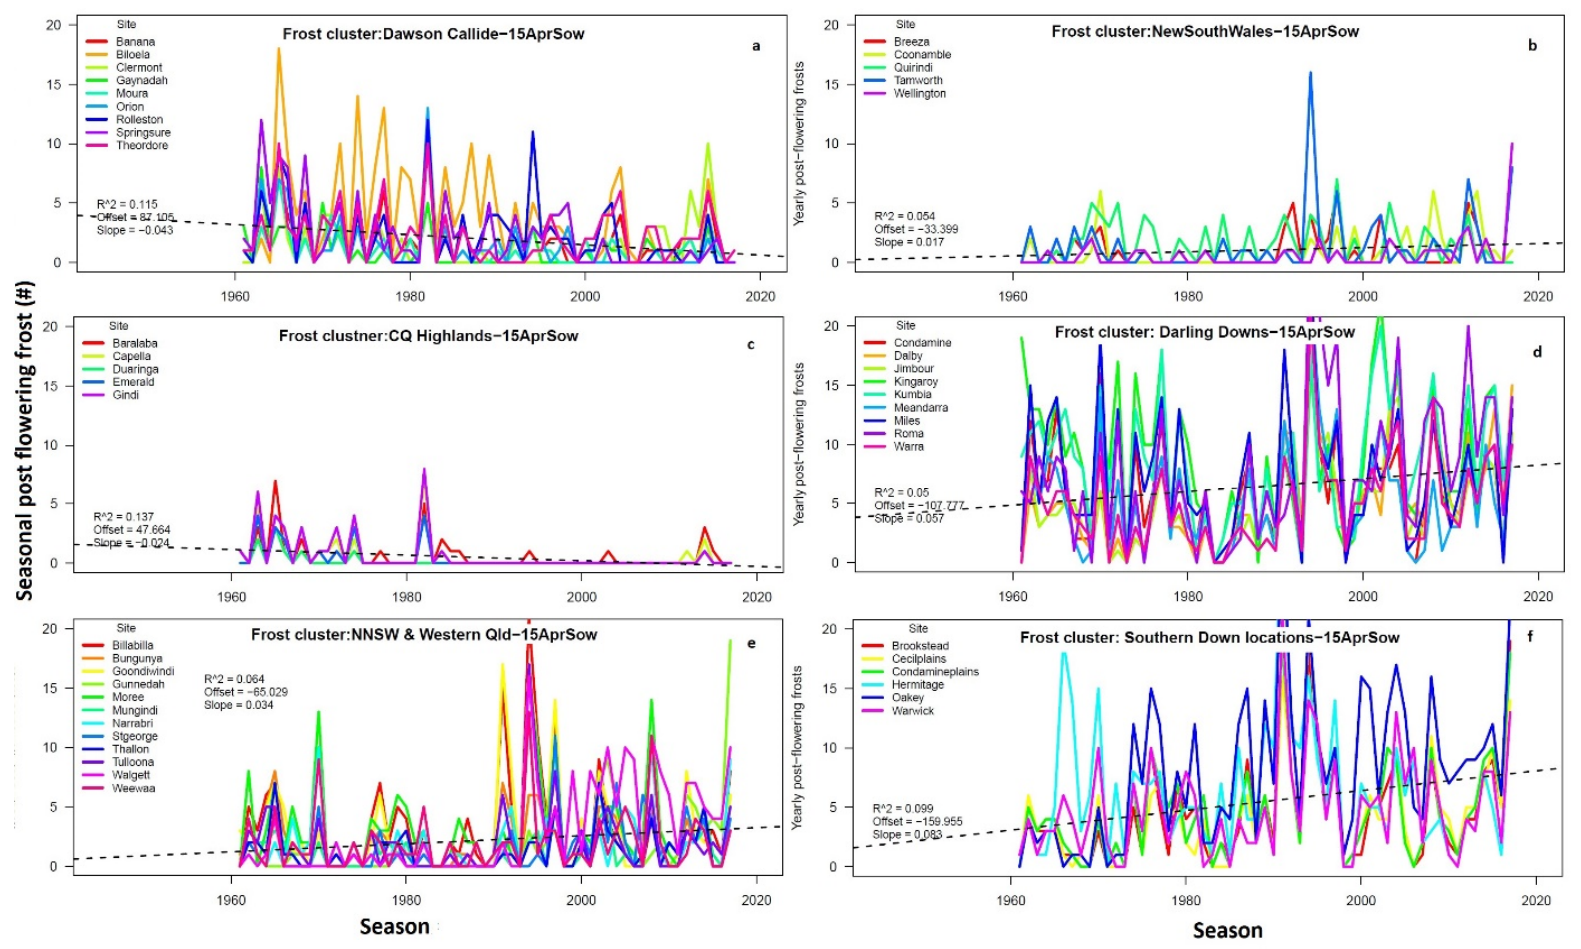
Figure 4. Temporal trends of 56 years in post-flowering frost frequencies for 15-April sowing for locations of Dawson Callide ( a ), New South Wales ( b ), Central Queensland Highlands ( c ), Darling Downs ( d ), Northern New South Wales and Western Downs ( e ) and Southern Downs ( f ) sub-regions. The dashed line shows increasing and decreasing trend (the adjacent values indicate coe ffi cients of determination (R 2 ), intercept (o ff set) and slopes of regression lines).